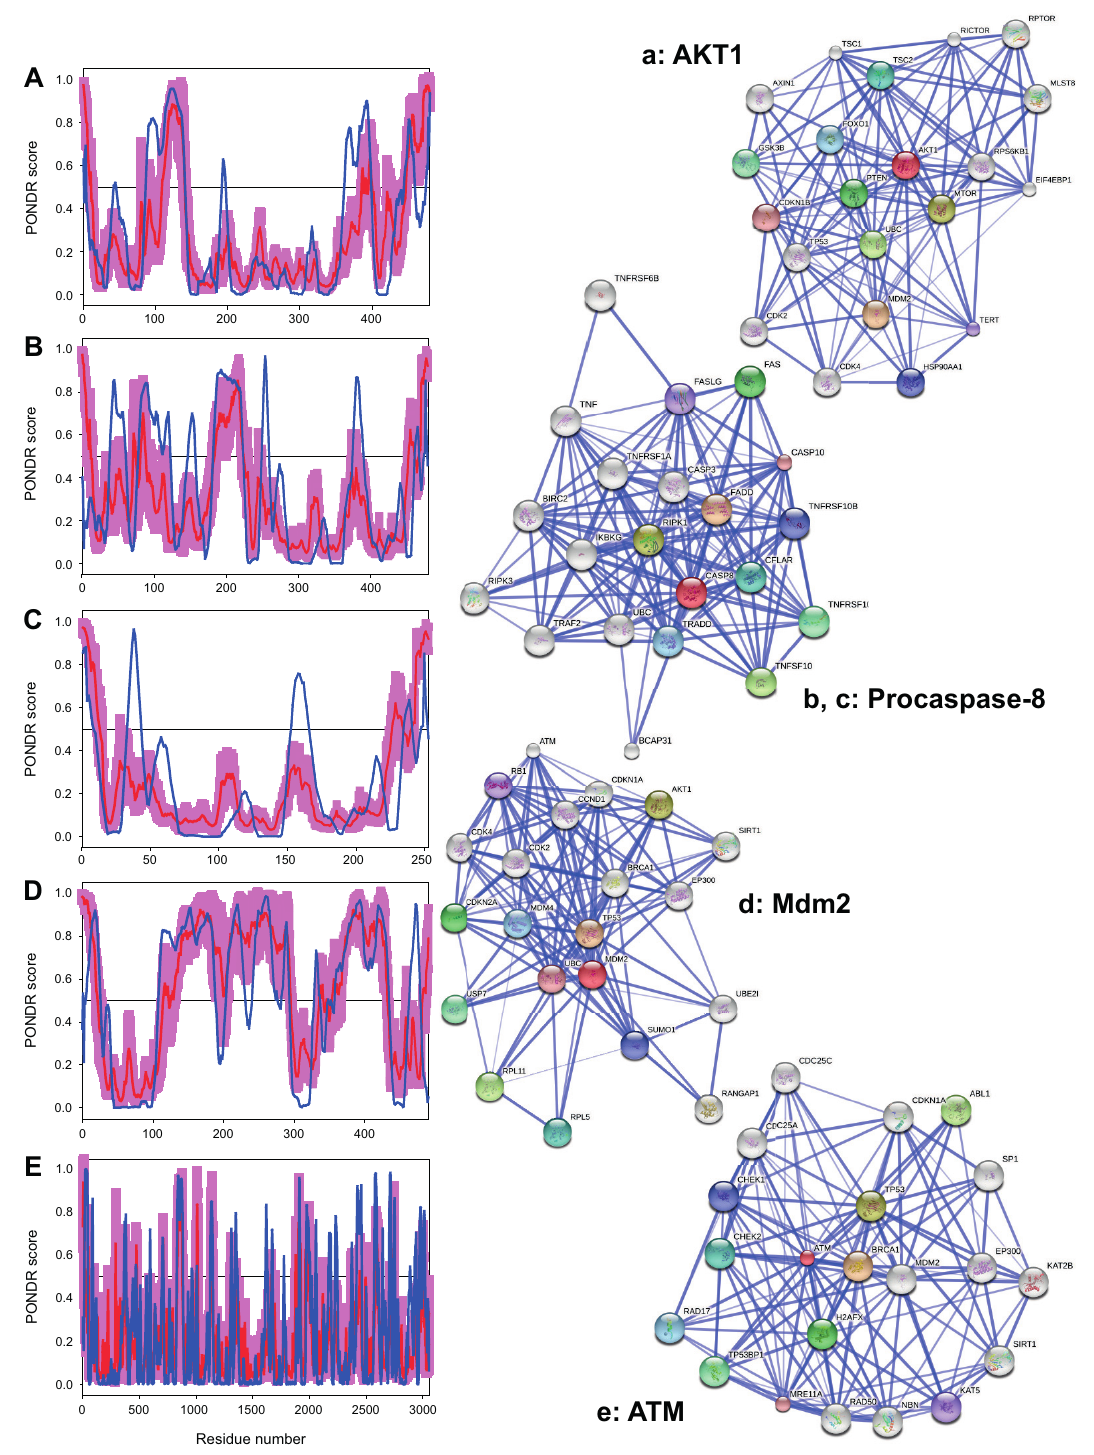
Figure 5. Intrinsic disorder (upper characters) of some human proteins involved in the p53-mediated apoptotic signaling pathways and STRING analysis (lower characters) of their interactomes: group III. A . and a . AKT1 (UniProt ID: P31749); B . and b . Procaspase-8 (UniProt ID: Q14790); C . and c . Caspase-8 (residues 217–374 and 385–479; ID: Q14790); D . and d . Mdm2 (UniProt ID: Q00987); E . and e . ATM (UniProt ID: Q13315). Intrinsic disorder propensity was evaluated by PONDR-FIT (red curves and pink shadow) and PONDR ® VLXT (blue curves). The